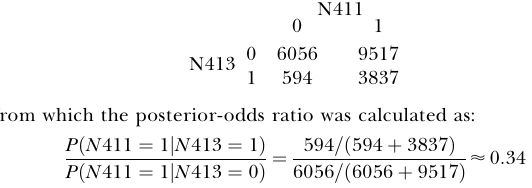
Figure S1. Frequency of PNGSs per Codon Position in HIV-1 Envelope Sequences Codon positions are numbered according to the alignment of HIV-1 envelope sequences. The approximate locations of variable loop regions and the transition between the gp120 and gp41 glycoprotein- coding domains are marked for reference. The frequency of PNGSs is